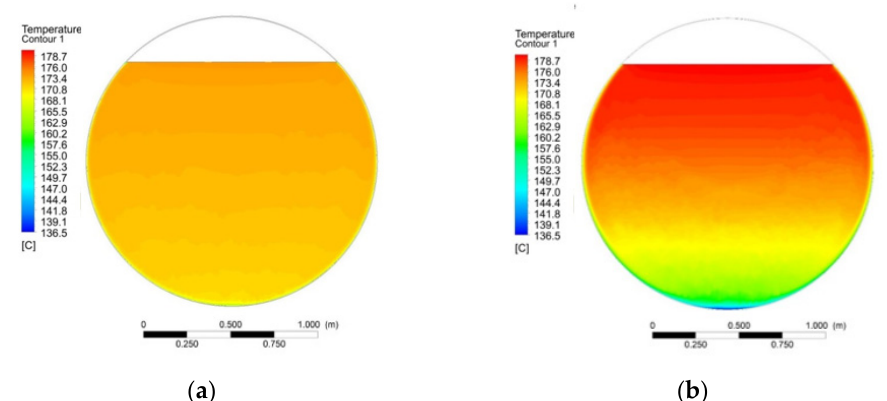
Figure 2. Layers of the thermal field of the liquid after 60 h: ( a ) with the viscosity of 6 Pa·s; ( b) with the viscosity of 100 Pa·s.